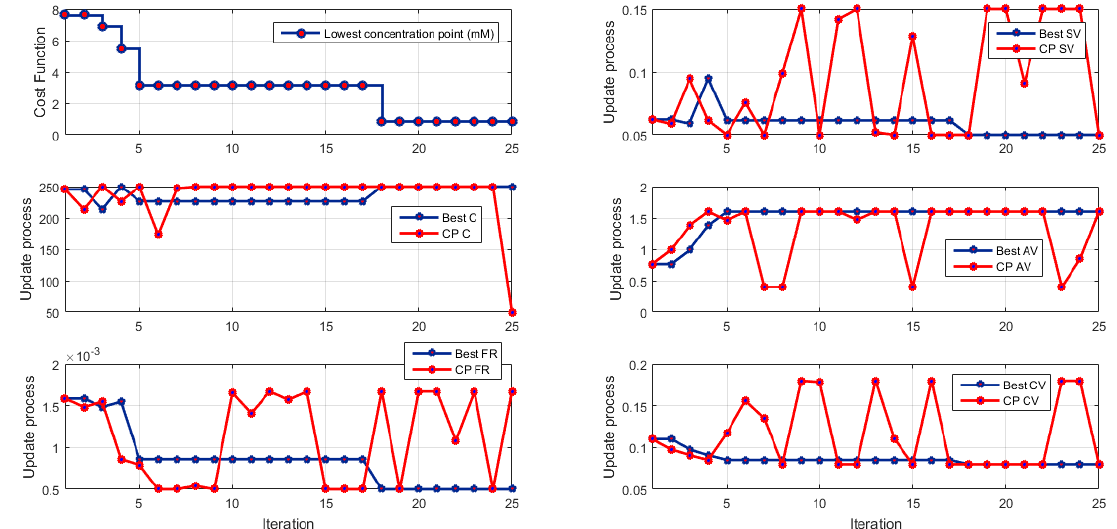
Figure 6. The cost function variation, best values of decision variables during the optimization process of the lowest concentration point. C is the capacitance, CP is the center point, FR is the flow rate, SV is the spacer volume, AV is the applied voltage, and CV is the cell volume.